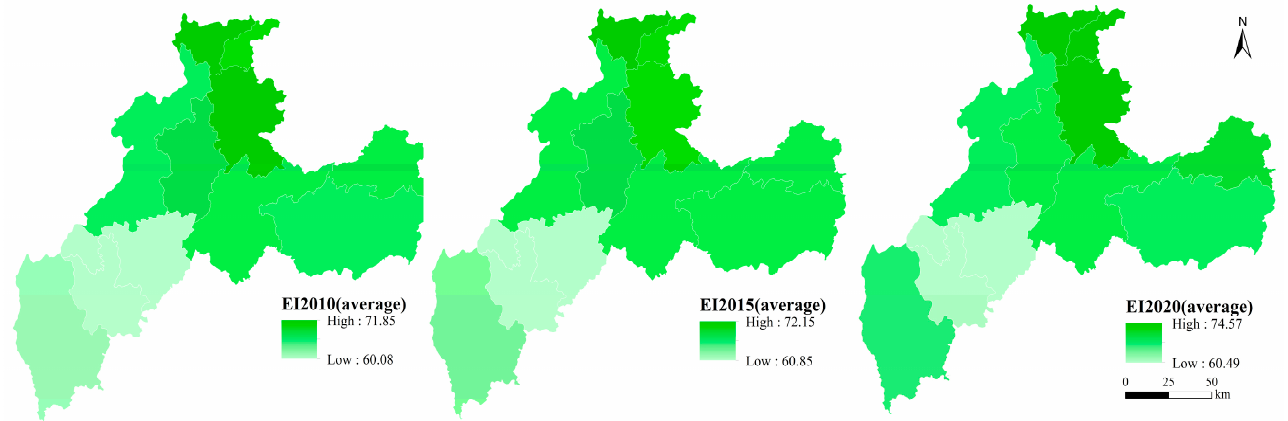
Figure 10. Spatial distribution map of average EI value from 2010 to 2020.